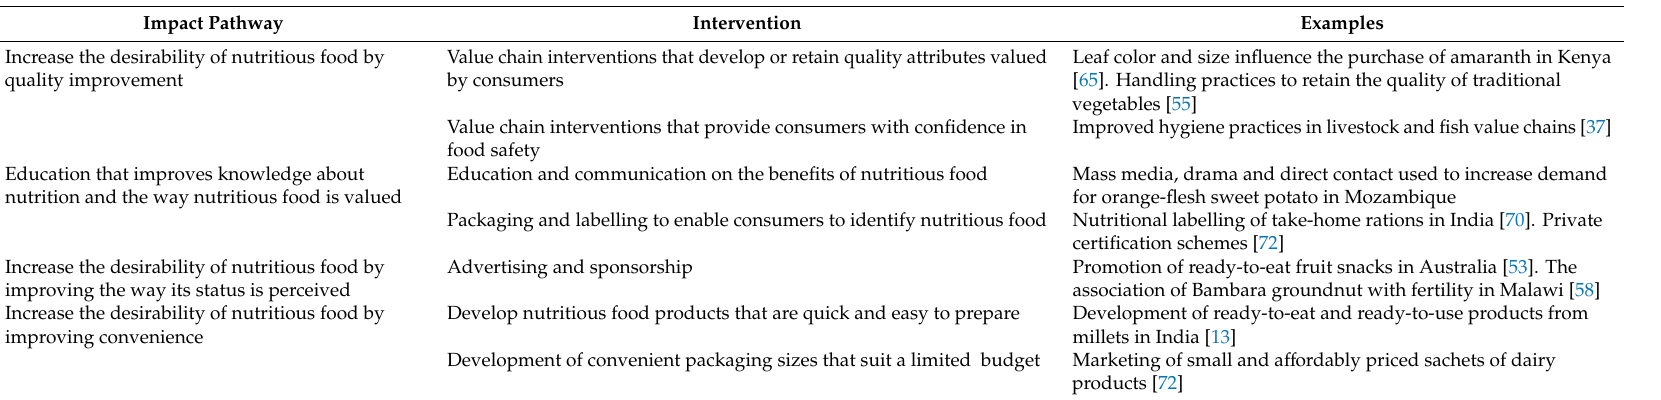
Table 4. Summary of value chain interventions with potential to improve diet quality through increasing the desirability of nutritious food in the local food